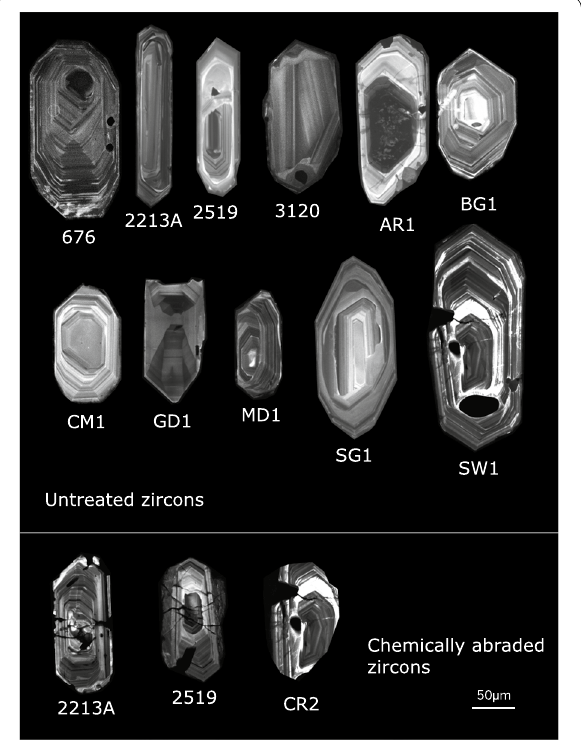
Fig. 2 Representative CL images from some of the dated lithologies. Upper panel, untreated grains; lower panel, chemically abraded grains. Full set of CL images of all analyzed zircon grains may